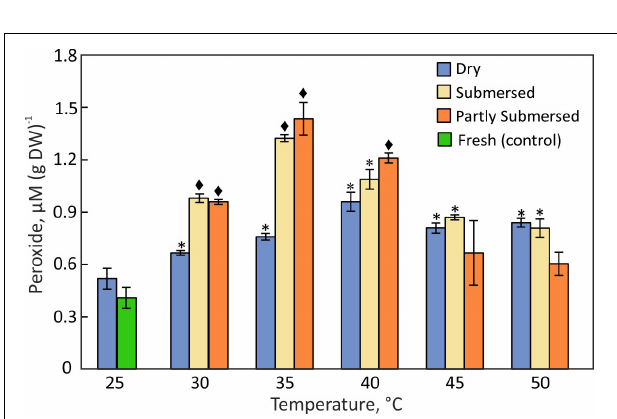
FIGURE 6 | Reduction of resazurin in dried fronds and hydrated (fully and partly submersed) fronds exposed to heat for 24 h. The metabolic activity of heat treated dry and hydrated fronds is compared with 25 ◦ C dry and fresh (control), respectively. Significant differences between treated and controls are indicated by * ( P ≤ 0.05) and (cid:7) ( P ≤ 0.001); means ± SE, n = 6.